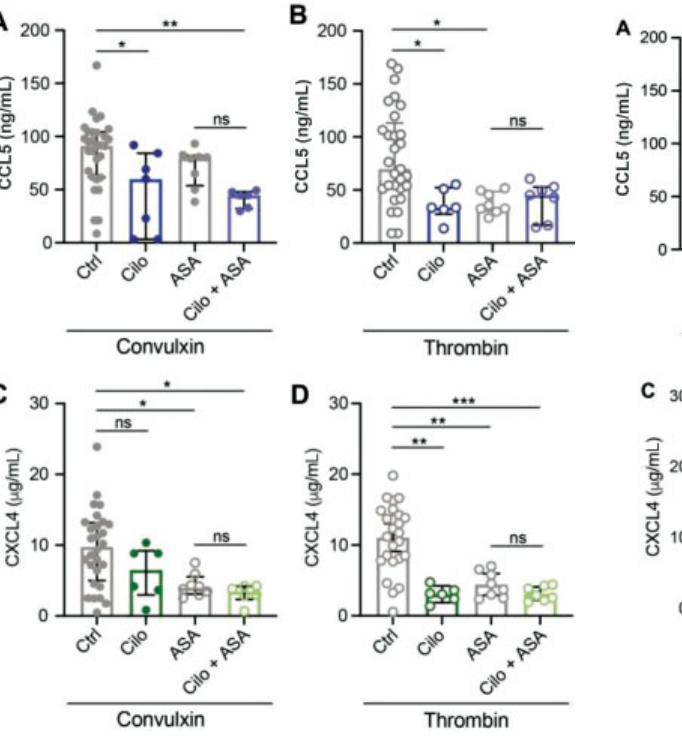
Fig. 5 Dual treatment with acetylsalicylic acid (ASA) þ cilostazol treatment has no additional effects on chemokine release. Washed platelets (2 (cid:1) 10 8 /mL) from healthy volunteers exposed to ASA (100mg p.o.) were activated and CCL5 ( A, B ) and CXCL4 ( C, D ) release was determined as described. Platelets were incubated 10minutes prior to activation with the PDE3 inhibitor cilostazol. Closed circles represent convulxin activation and open circles represent thrombin activation. CTRL: n ¼ 25 – 29; Cilo: n ¼ 6; ASA: n ¼ 8; and ASA þ Cilo: n ¼ 6. Median with interquartile range. (cid:4) p < 0.05; (cid:4)(cid:4) p < 0.01; and (cid:4)(cid:4)(cid:4) p < 0.001; analysis of variance with Sidak test.